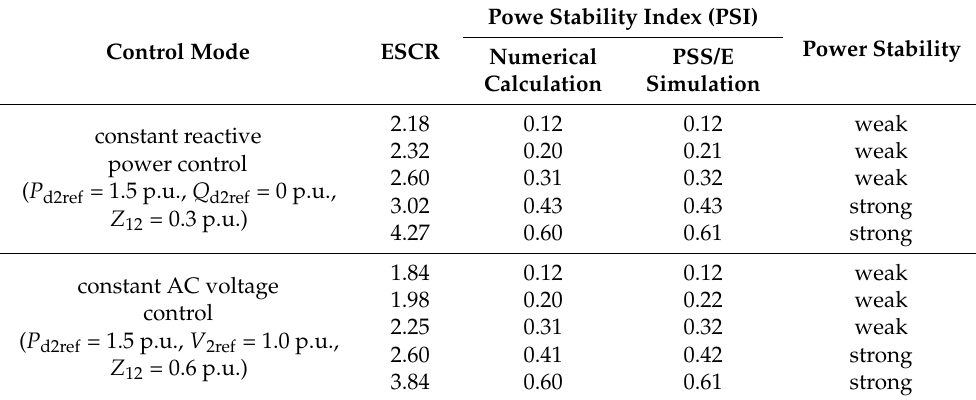
Table 2. LCC-HVDC power stability index under different receiving-end system